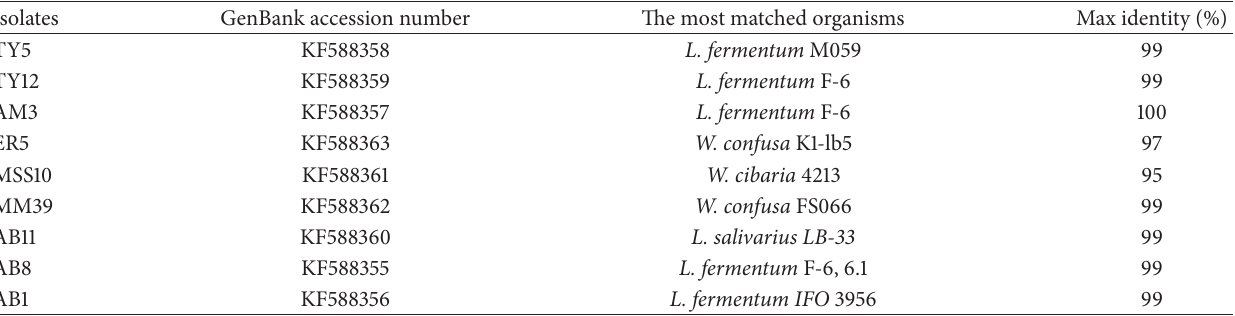
Table 4: Identification of oxalate degrading LAB strains by 16S rDNA sequences.